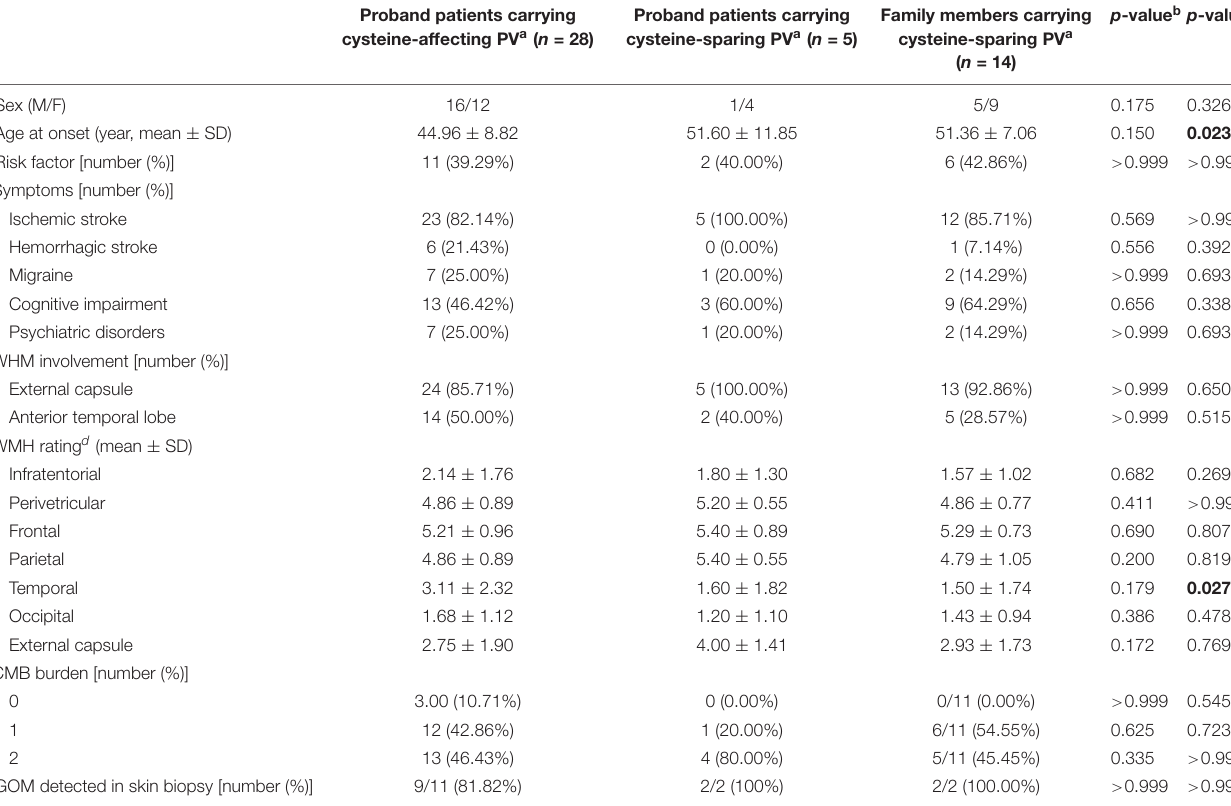
TABLE 5 | Comparison of clinical features between patients carrying cysteine-affecting and cysteine-sparing pathogenic NOTHC3 variants. Proband patients carrying cysteine-affecting PV a ( n =